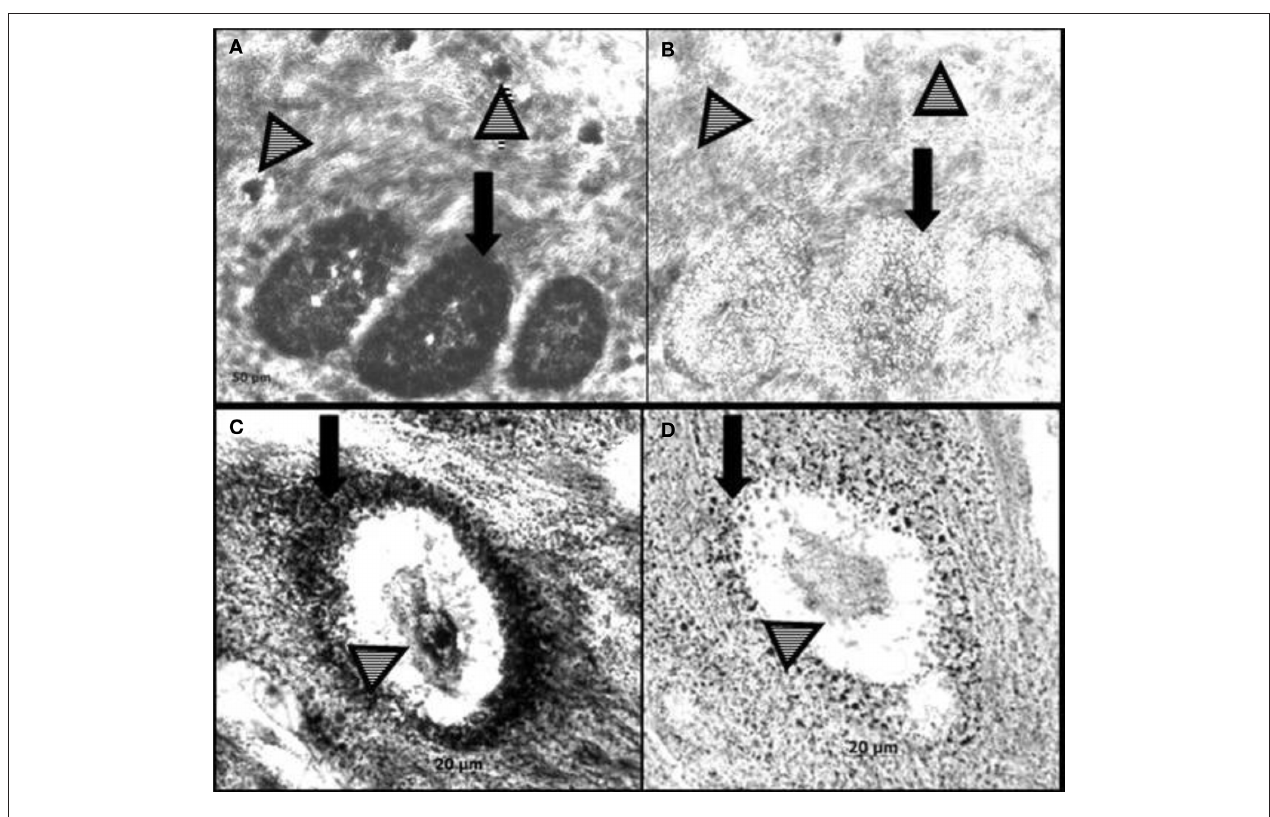
FIGuRe 2 | In situ hybridization for RF-amide related peptide (RFRP) and its receptor (OT7T022) in rhesus macaque ( Macaca mulatta ) ovary. RFRP antisense probe labels mRNA in granulosa cells and oocytes (A) . An adjacent section incubated with RFRP sense probe (control) is